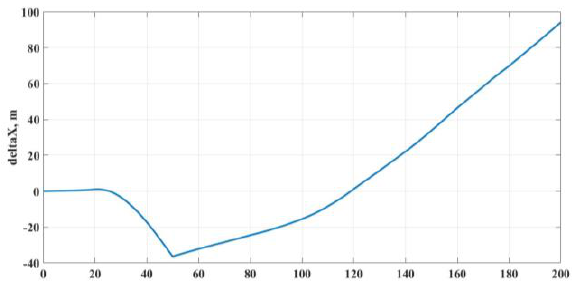
Figure 12. Changing of INS error along X axis, including wind gust